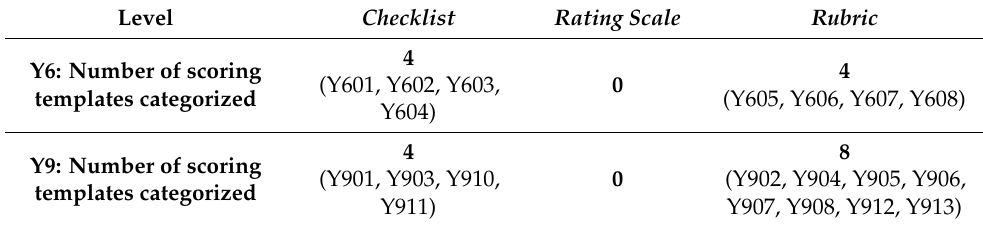
Table 5. Categorization of STs for Y6 and